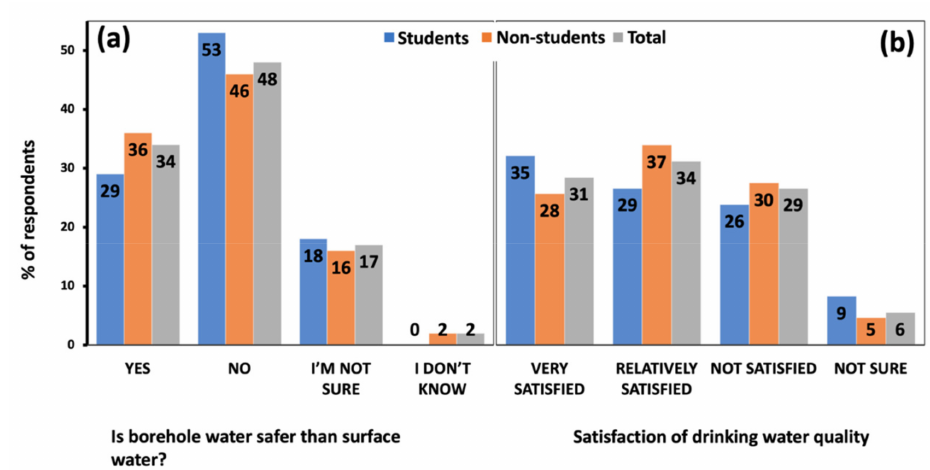
Figure 4. The percentage of respondents indicating their trust on the safety ( a ) and satisfaction of the quality ( b ) of their drinking water.